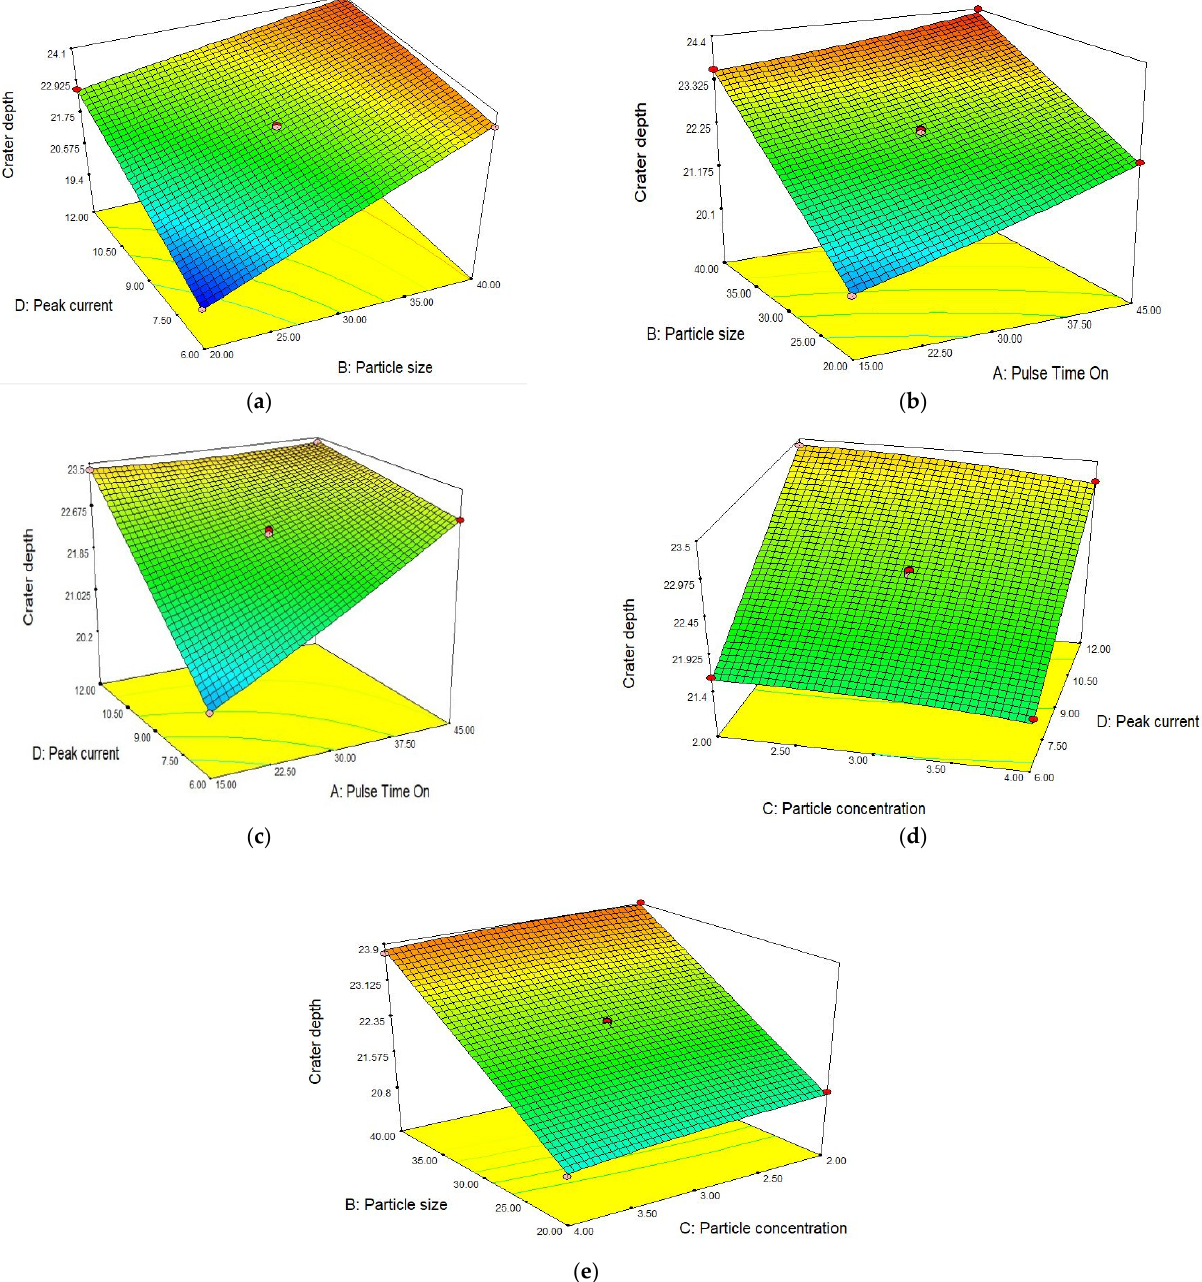
Figure 12. Effect of different parameters on craters depth, ( a ) Peak current vs. particle size, ( b ) Pulse time on vs. particle size, ( c ) Pulse time on vs. peak current, ( d ) Peak current vs. particle concentration, ( e ) Particle size vs. particle concentration.